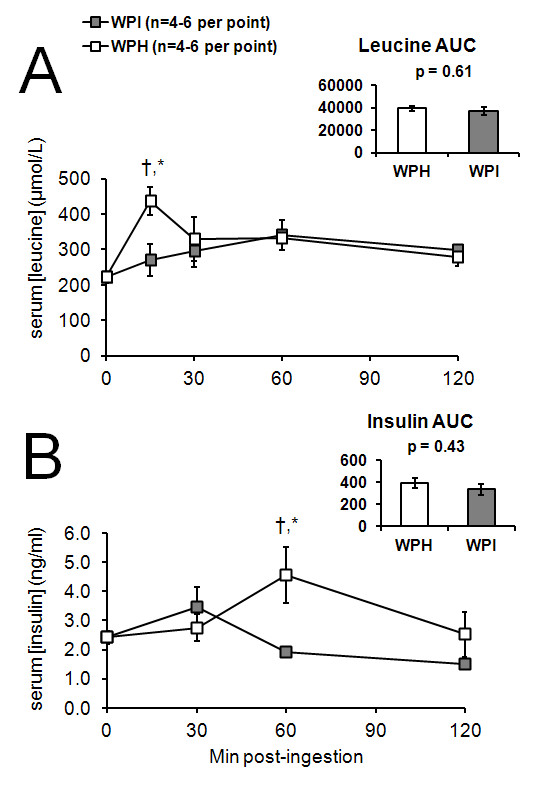
Circulating postprandial leucine (A) and insulin (B) responses of a WPH-based supplement versus WPI. Inset figures represent postprandial areas under the curve (AUCs) of each condition. All data are presented as mean ± SE; n = 4–6 rats per time point. Abbreviations/symbols: † = greater serum value than 3-h fasting concentrations for the respective supplement; * = WPH > WPI at a postprandial time point (p < 0.05).